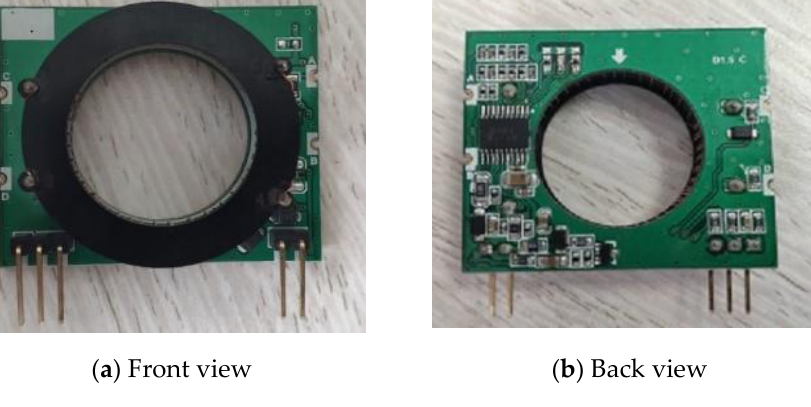
Figure 13. Dc leakage sensor real figure.